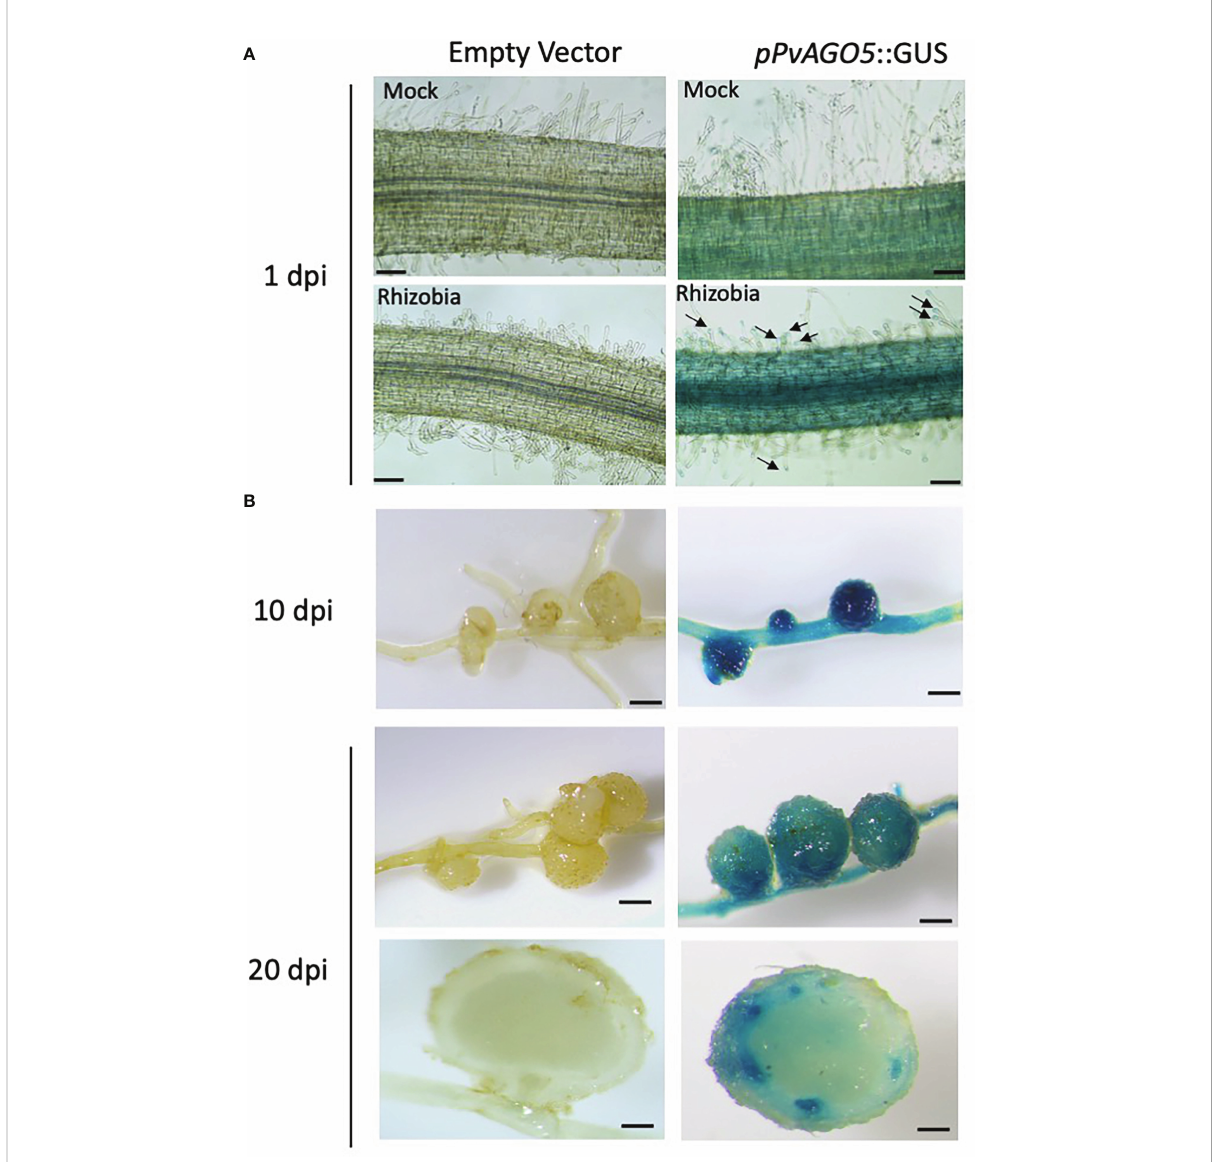
FIGURE 2 PvAGO5 is expressed in nodule primordia and mature nodules. P. vulgaris composite plants with transgenic roots expressing either the empty vector or the construct pPvAGO5:GUS-GFP were grown under low-nitrogen conditions and inoculated with R. tropici CIAT899. One (A) , ten and twenty days after inoculation with rhizobia, transgenic roots showing rhizobia-induced deformed root hairs (A) , or containing nodule primordia ( B , middle panel) or mature nodules ( B , last four panels) were collected and stained for three hours at 37°C. Roots expressing the pPvAGO5:GUS-GFP construct displayed GUS signal throughout the whole root and in the tip of root hairs ( A , black arrows). A strong GUS signal was detected in nodule primordia and in mature nodules ( B , middle panel). Scale bars represent 100 m m for pictures shown at panel A, and 1 mm for fi gures shown at panel B. Images shown are representative of ten biological replicates, each one containing ten transgenic